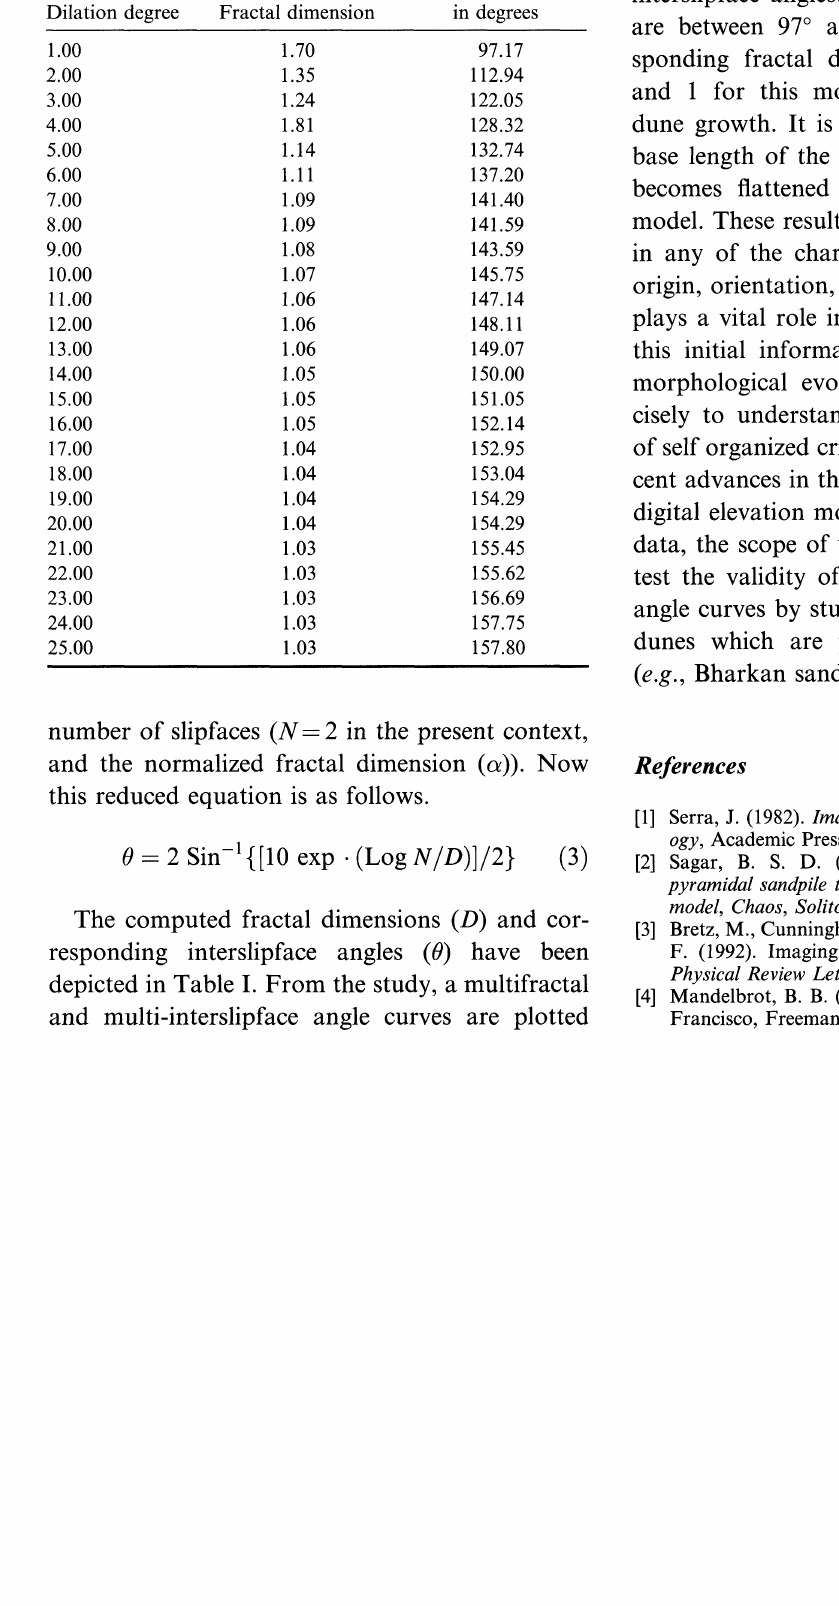
TABLE Fractal dimensions and corresponding interslipface angles Dilation degree Fractal dimension